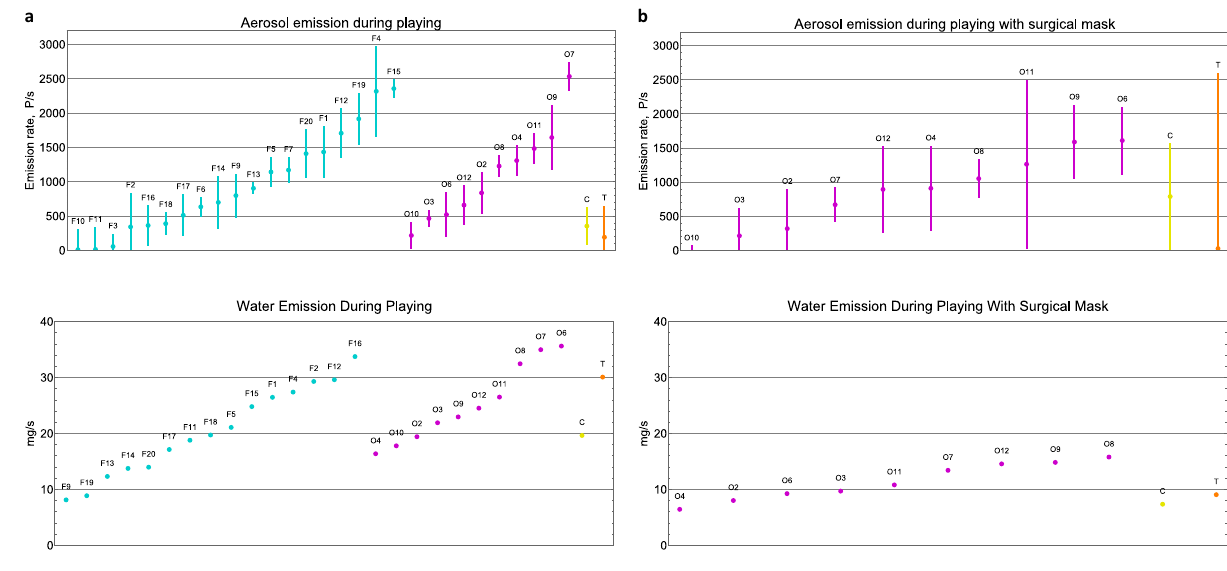
Figure 3. Distribution of aerosol and water emission rates during wind instrument playing without ( a ) and with ( b ) a surgical mask around the bell. F flute, O oboe, C clarinet, T trumpet. Numbers indicate participant’s ID. Wind instrument playing lasted 20 min; oboe, trumpet, and clarinet playing with a surgical mask lasted 10 min. Emission rates are reported as particles/second (P/s), water emission rates as mg/s. Error bars indicate standard deviations of estimation uncertainty according to bootstrap calculation.